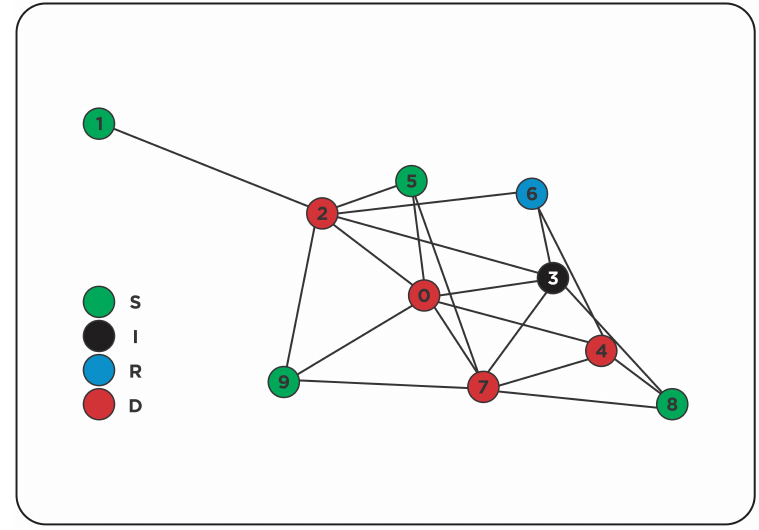
Figure 4. SIRD network model.